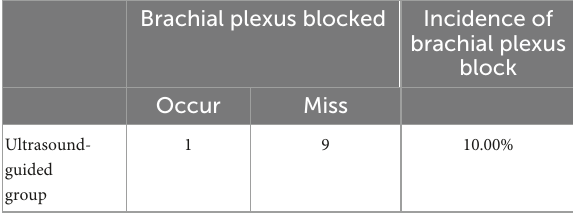
TABLE 1 Incidence rate of brachial plexus block with lidocaine injection volume within 95% CI of the lowest effective